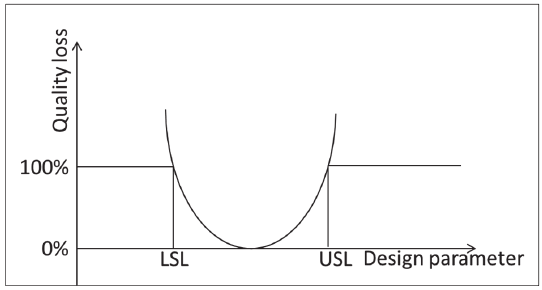
Fig. 1. Quadratic quality loss